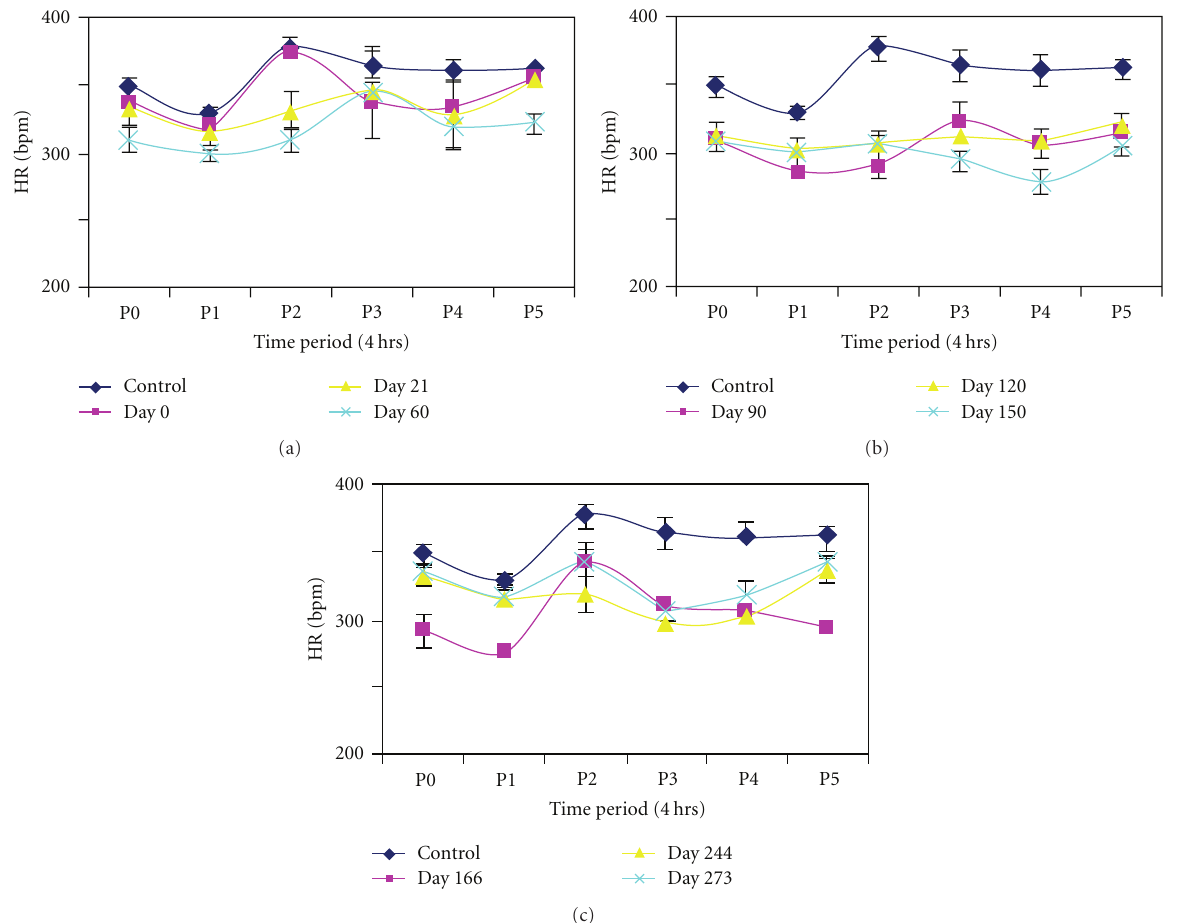
Figure 3: Circadian variations in heart rate (HR) in six diurnal (4 hour) periods (P0–P5) at (a) 0–60 days, (b) 90–150 days, (c)166–274 days after diabetic conversion. Values are means ± SEM. Note the near consistent relationships with changes in arterial pressure findings (Figure 2) in terms of